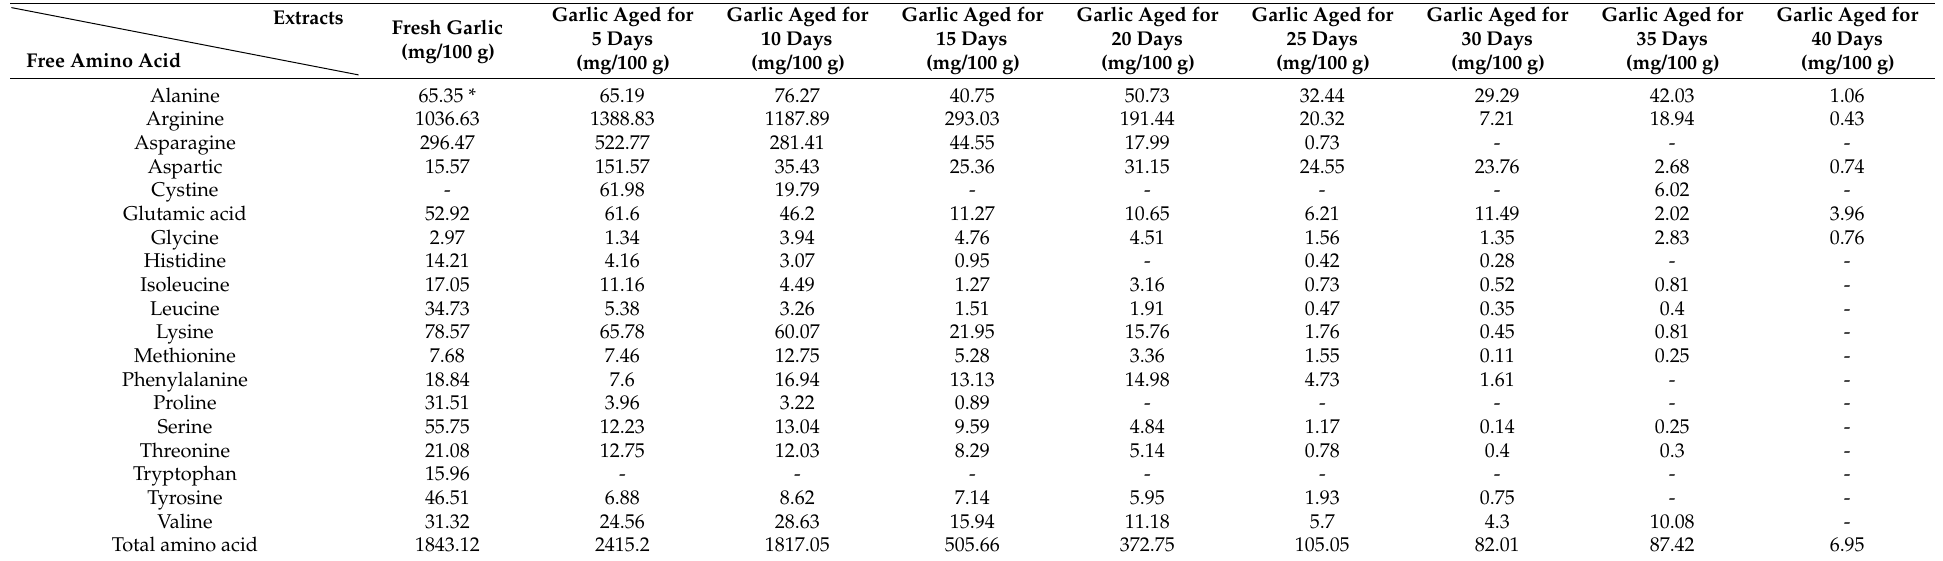
Table 2. Free amino acids in fresh garlic and garlic aged for different